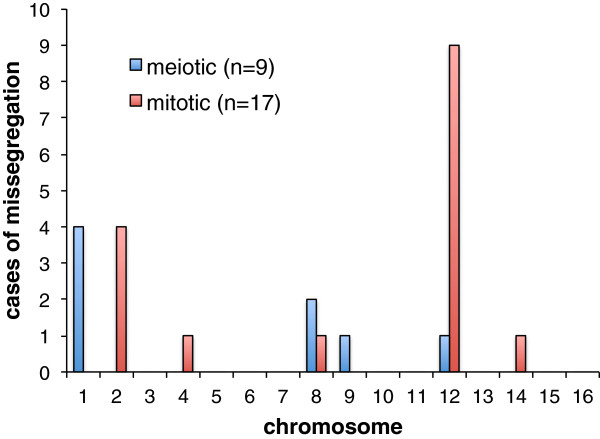
Frequency of disomies across all chromosomes. These disomies were detected in our set of 768 segregants and classified into missegregations during meiosis or mitosis depending on the respective allele frequencies (0.5 or 1) and copy number.